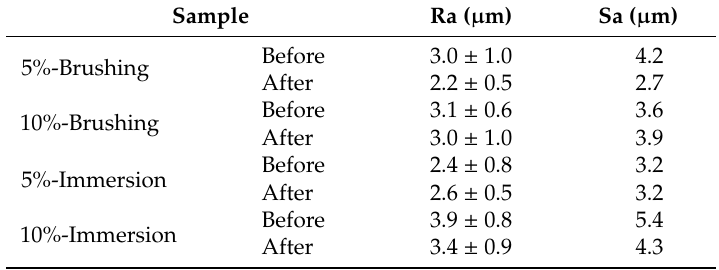
Table 2. Roughness parameters Ra ( µ m) and Sa ( µ m) obtained by optical profilometry. The parameters were evaluated before and after the surface treatment for each